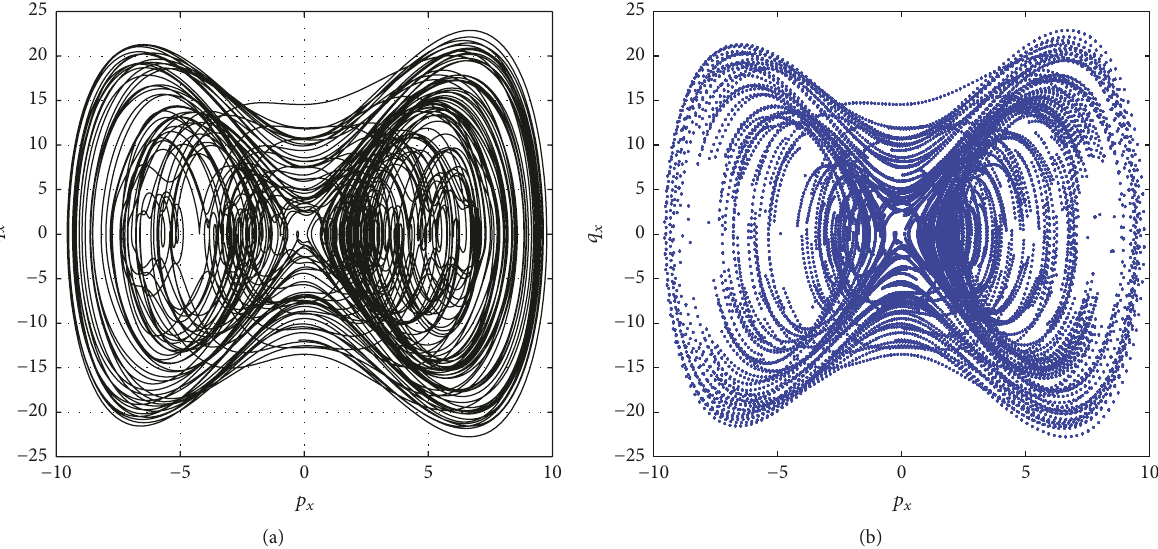
Figure 4: Phase portrait (a) and Poincar´e sections (b) in the plane 𝑝 𝑥 ,𝑞 𝑥 with the initial conditions 𝑞 𝑥𝑜 = 1 , 𝑞 𝑦𝑜 = 1 , 𝑝 𝑥𝑜 = 3 , 𝑝 𝑦𝑜 = 7 , 𝜌 𝑥𝑜 = 1 , 𝜌 = 1 , 𝜉 = 4 , and 𝜉 = 3 . We set the linear coupling parameters as 𝜎 = 0.2 , 𝜅 = 200 , and 𝛼 = 0.1 𝑦𝑜 𝑥𝑜 𝑦𝑜